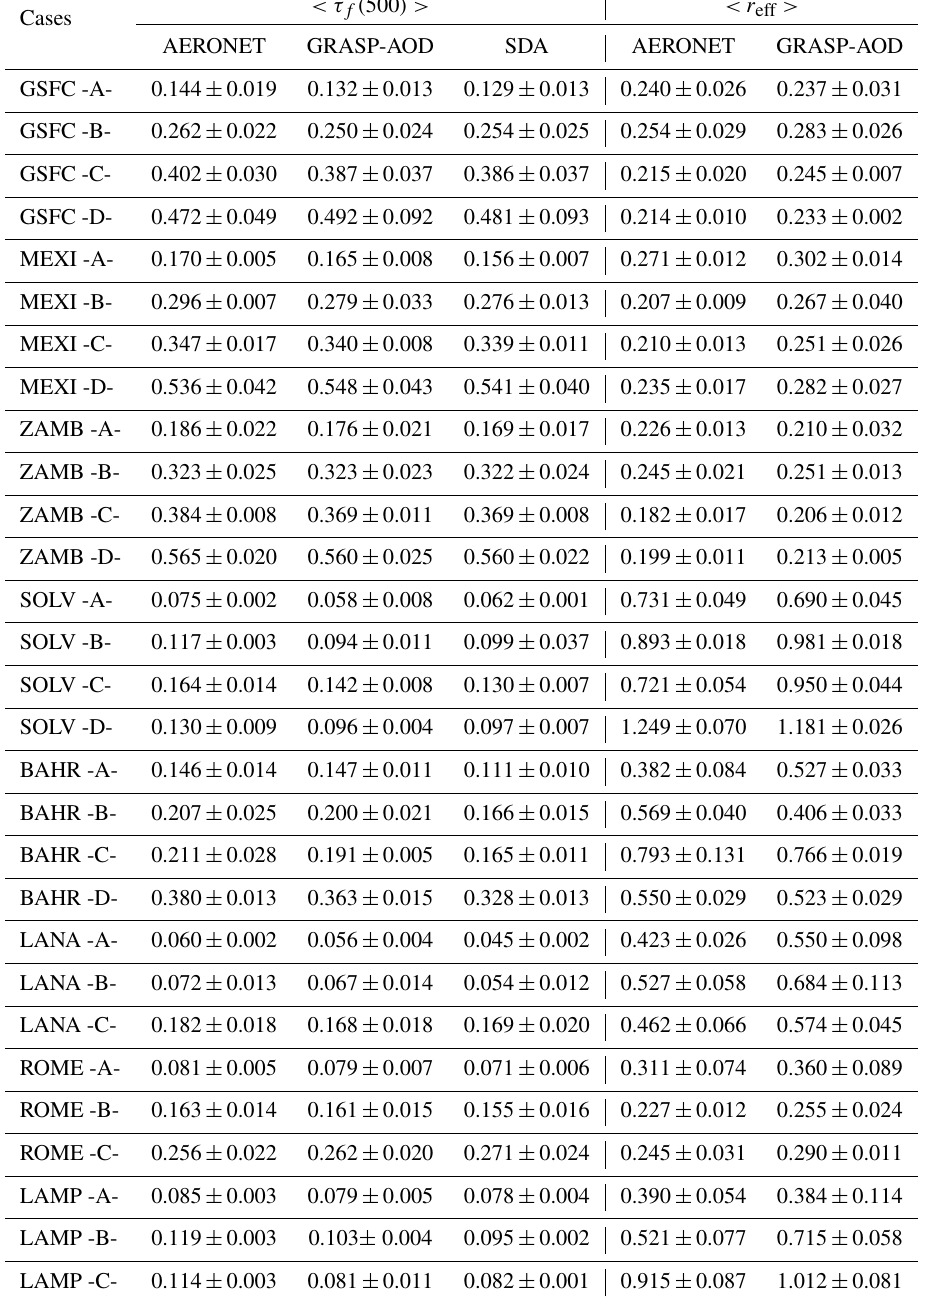
Table 15. Daily averages of the retrieved products < τ f ( 500 ) > and r eff . The values of < τ f ( 500 ) > are computed with three different algorithms for the 29 chosen days: AERONET, GRASP-AOD and SDA. The effective radius is computed with the standard AERONET and GRASP-AOD